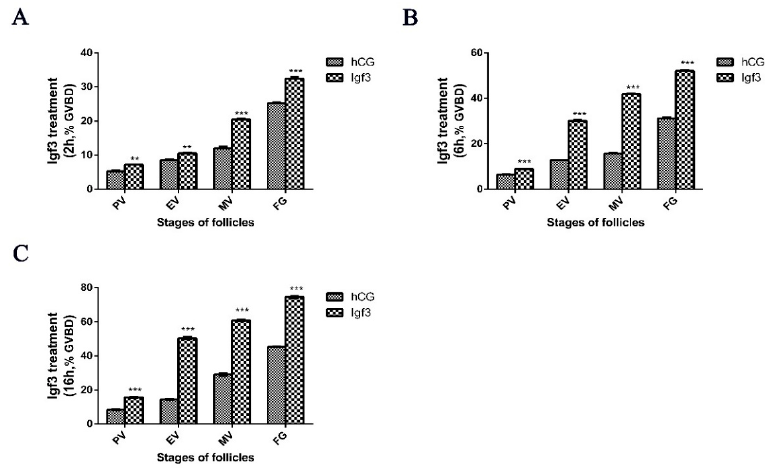
Figure 6. Effects of Igf3 on follicular Germinal vesicle breakdown (GVBD) in the previtellogenic (PV), early vitellogenic (EV), midvitellogenic (MV) and fully-grown (FG) stages of development. Cells were treated for ( A ) 2, ( B ) 6 and ( C ) 16 h. ( n = 4). **, p < 0.01, ***, p < 0.001.